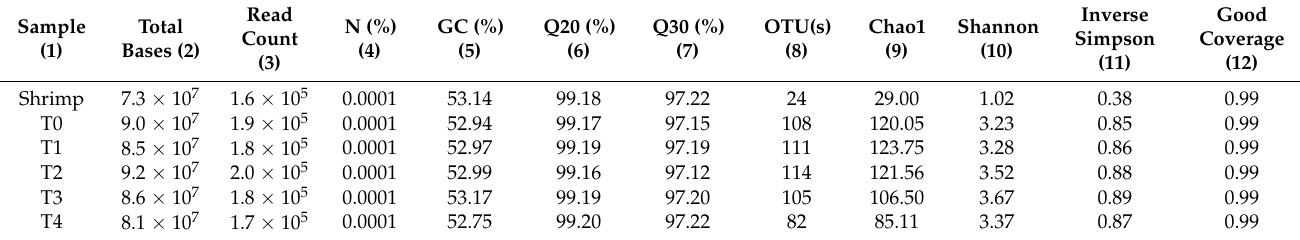
Table 3. The summary of Illumina sequencing of V3–V4 regions of 16S rRNA, assembled by the FLASH program, showing the quality of the sequencing results (columns 2 to 7). OTUs of metagenome bacteria and diversity index from shrimp and low-salt terasi, analyzed by the QIIME program (columns 8 to